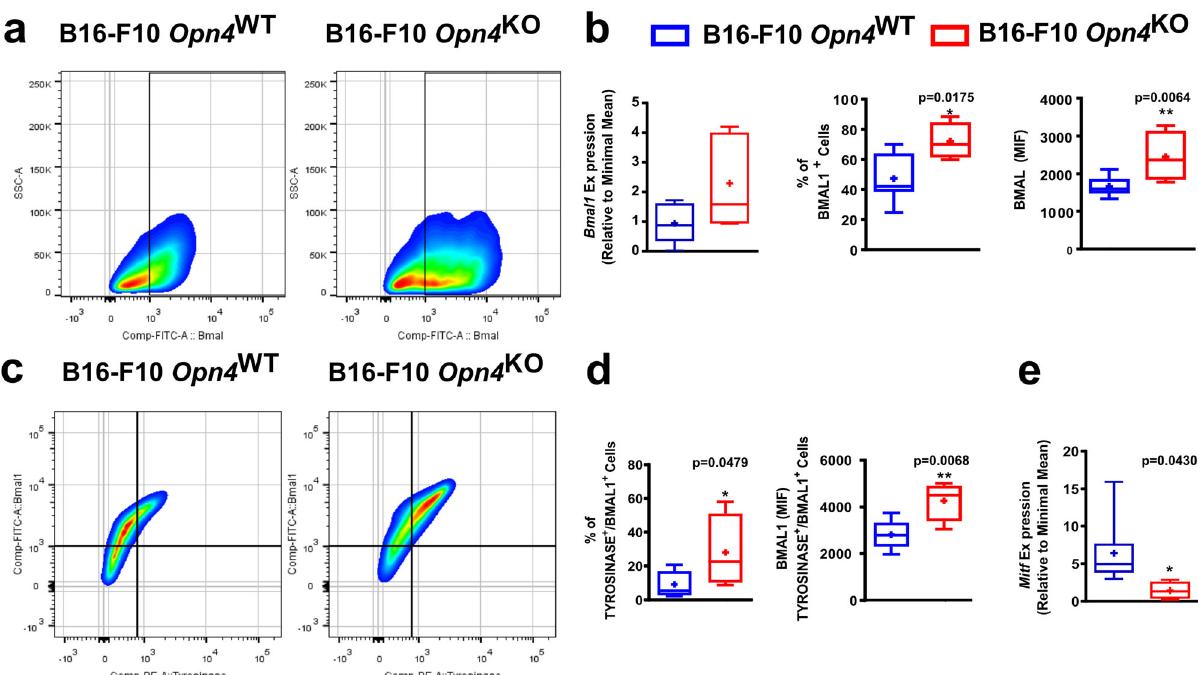
Fig. 5 Evaluation of BMAL1 in tumor bulk and in TYROSINASE-positive cells in Opn4 WT and Opn4 KO tumors. BMAL1 and MITF gene and protein expression. a and c Representative gates of fl ow cytometry assay. b Gene expression of Bmal1 and frequency and fl uorescence of BMAL1 positive cells. d Percentage and quanti fi cation of BMAL1 fl uorescence in TYROSINASE and BMAL1 positive cells in Opn4 WT and Opn4 KO tumors. e Gene expression of Mitf in tumor bulk. In b (qPCR), n = 8 and 5, for Opn4 WT and Opn4 KO tumors, respectively. In b and d (FACS), n = 8 and 4, respectively; ( e ), n = 8 and 4, respectively. In every analyzes, the n number is derived from independent